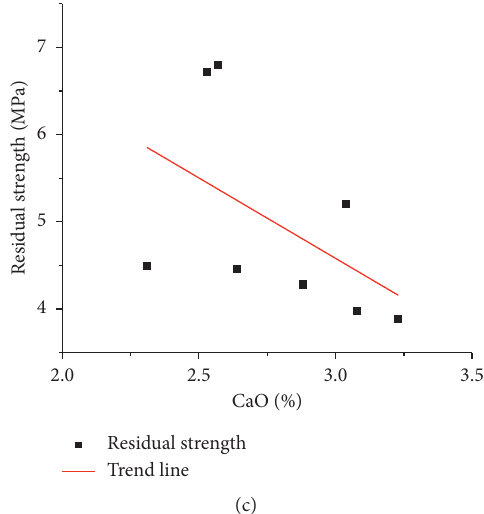
Figure 8: Relationship between mineral composition and residual strength of deep sandstone reservoir.